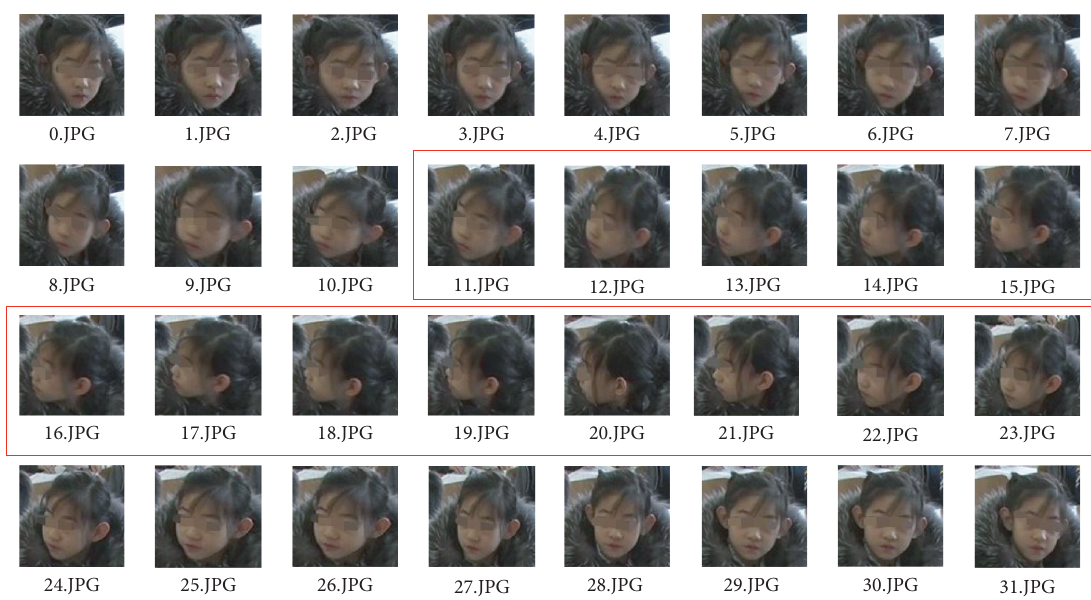
Figure 5: Example of individual attentional concentration